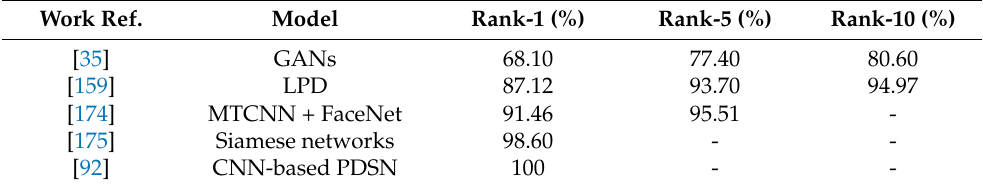
Table 6. A comparison of ranked accuracies achieved by MFR approaches. Work Ref.